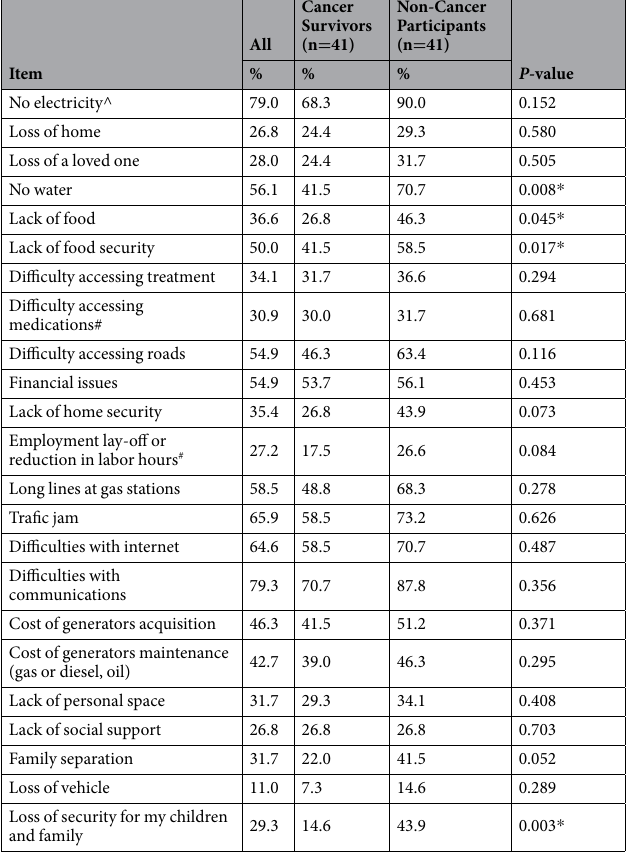
Table 3. Natural Disaster Outcomes Questionnaire responses by item from study participants. Reported as % of participants from each group that were affected by the outcome described by the item. ^Non-Cancer, n = 40; # Cancer, n = 40; * Significant Differences among cancer survivor group and non-cancer participants (p <